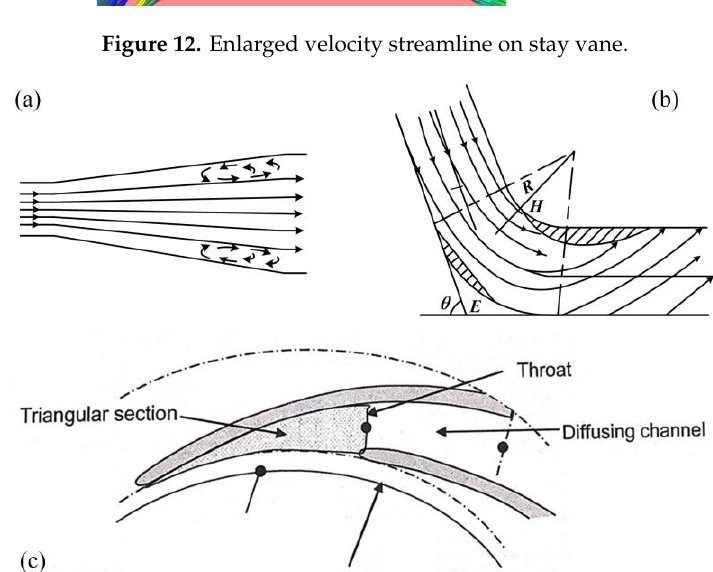
Figure 13. ( a ) Diffusion flow, ( b ) curved duct flow, and ( c ) diffusing channel of stay vane [26].